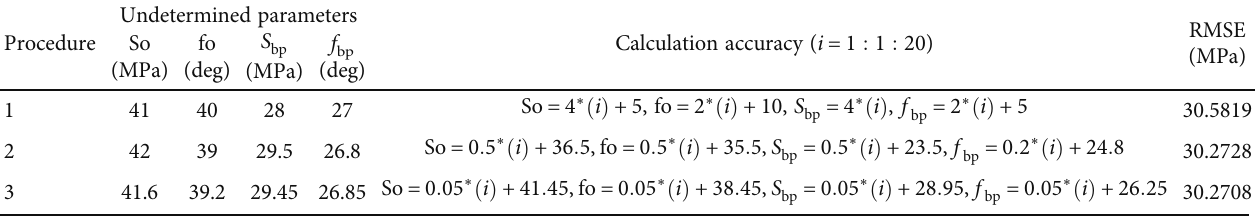
Table 1: Example of Iterative process for Jaeger ’ s plane of weakness